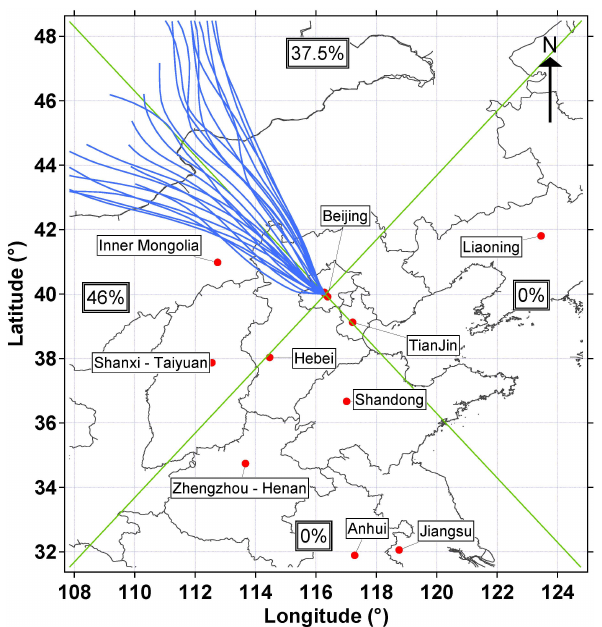
Fig. 7. Geographical map showing the 24-h backward trajecto- ries arriving at Beijing during the intensive winter measurements, reconstructed using the NOAA ARL HYSPLIT trajectory model